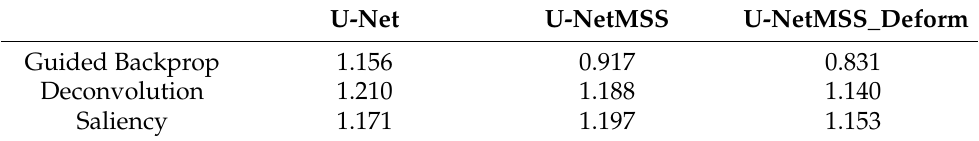
Table 2. Sensitivity